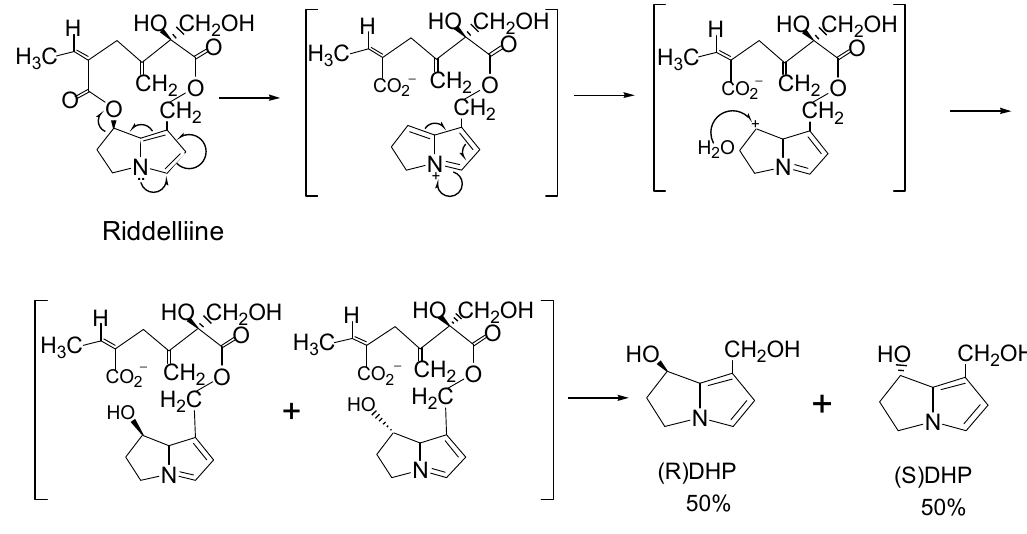
Figure 3. Scheme of metabolism of riddelliine leading to